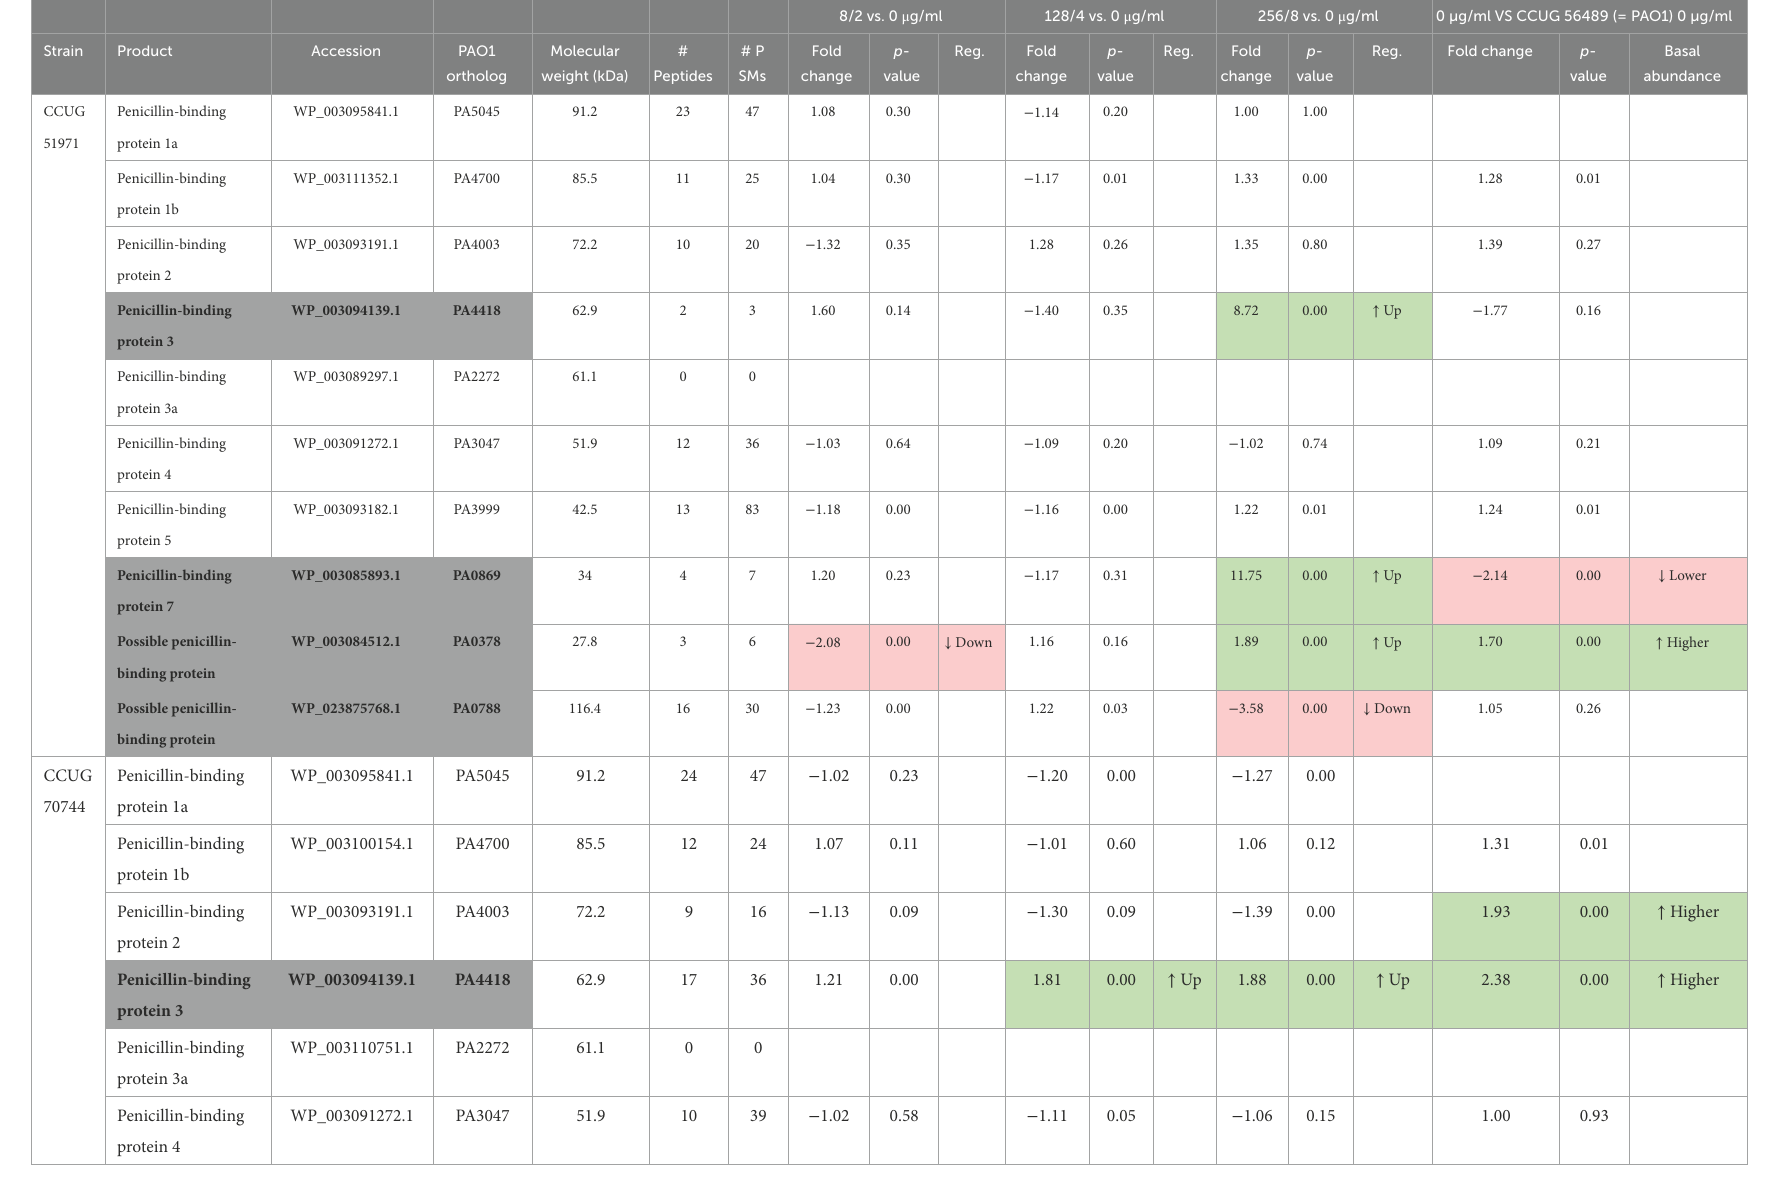
TABLE 6 Penicillin-binding proteins (PBPs) encoded by Pseudomonas aeruginosa CCUG 51971 and CCUG 70744 and their relative